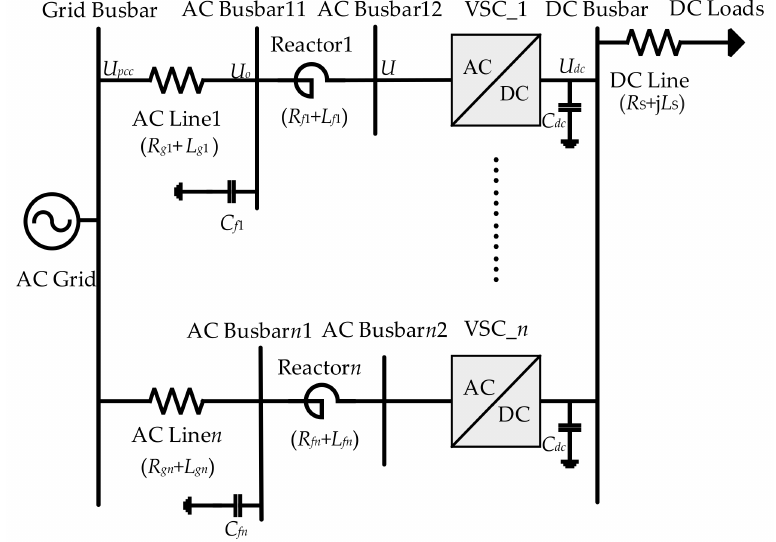
Figure 1. Topology diagram of the DC distribution system with parallel converters.